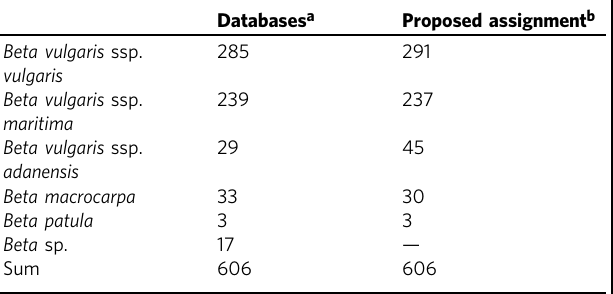
Particularly noteworthy is the increase in numbers of B. v . adanensis accessions (four of which are less evident than the others, see Table